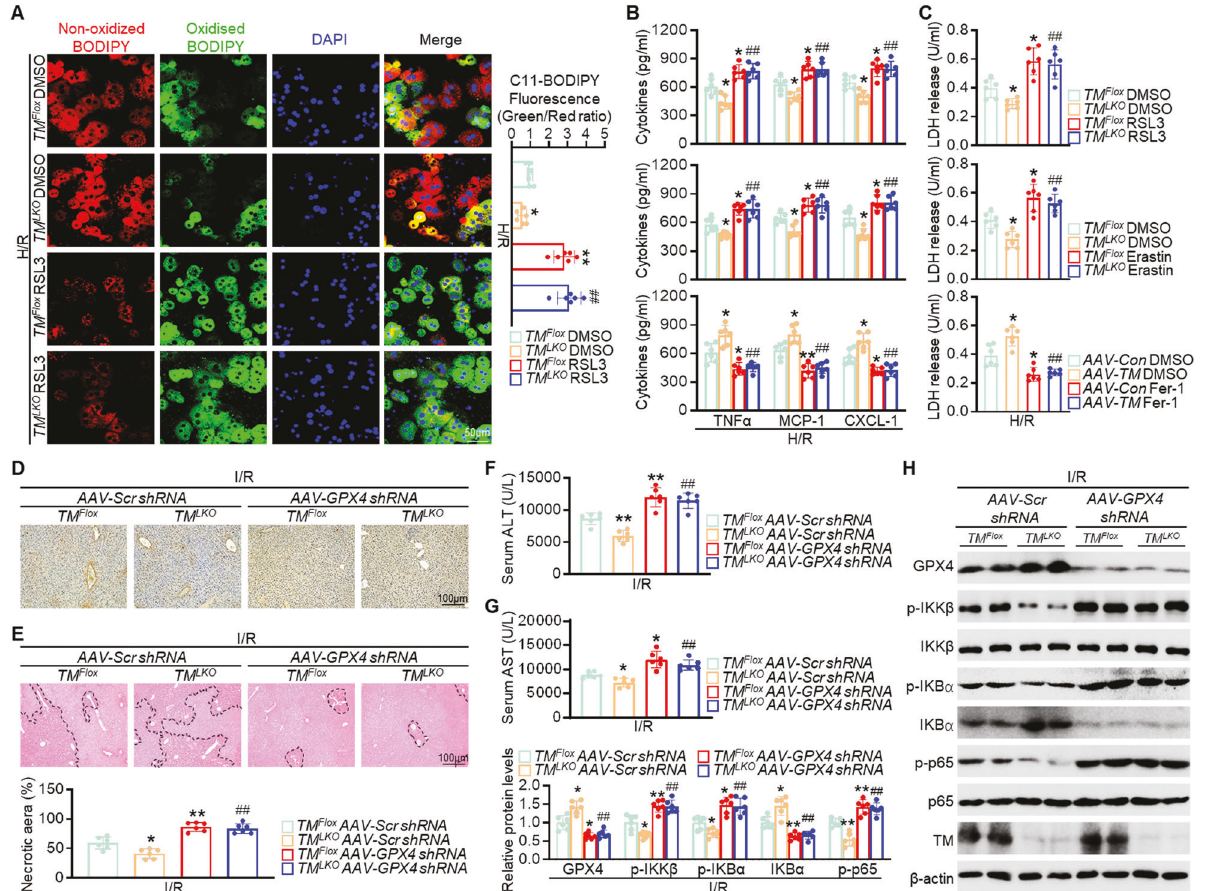
Fig. 5 TMEM16A regulates hepatic I/R injury in a GPX4-dependent manner. A Lipid ROS levels of primary hepatocytes isolated from indicated mice treated with RSL3 (3 μ moL/L) for 8 h followed by 4 h of hypoxia and 12 h of reoxygenation ( n = 6). Red, reduced form of C11- BODIPY; a green, oxidized form of C11-BODIPY. * P < 0.05, ** P < 0.01 versus TM Flox DMSO; ## P < 0.01 versus TM LKO DMSO. B Levels of pro- in fl ammatory factors (TNF- α , MCP-1, and CXCL-1) and C LDH release in indicated hepatocytes treated with RSL3, Erastin (10 μ moL/L), or Ferrostatin-1 (Fer, 2 μ moL/L) for 8 h followed by 4 h of hypoxia and 12 h of reoxygenation ( n = 6). * P < 0.05, ** P < 0.01 versus TM Flox DMSO or AAV-Con DMSO; ## P < 0.01 versus TM LKO DMSO or AAV-TM DMSO. D Representative 4-HNE immunohistochemical staining of liver samples from TM LKO and TM Flox mice injected with AAV-GPX4 shRNA via tail vein two weeks prior to I/R surgery ( n = 6). E Representative H&E staining of liver sections, necrotic area quanti fi cation (area outside the contour indicates the injured part in the last two pictures on the right side), and F serum ALT and G AST levels in indicated mice ( n = 6). * P < 0.05, ** P < 0.01 versus TM Flox AAV-Scr shRNA ; ## P < 0.01 versus TM LKO AAV-Scr shRNA . H Expression of proteins associated with the NF- κ B signaling pathway in liver samples from indicated mice ( n = 6). c versus TM Flox AAV-Scr shRNA ; ## P < 0.01 versus TM LKO AAV-Scr shRNA . Data were presented as the mean ±